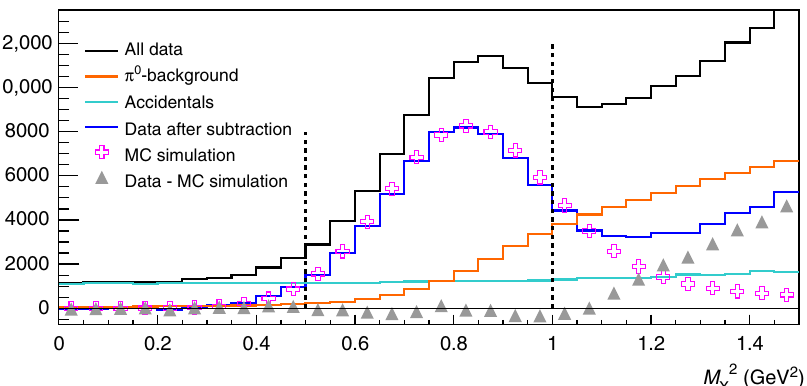
Fig. 3 Missing mass squared distribution. The black histogram presents the raw data. Accidental and π 0 backgrounds are shown in green and orange, respectively. The subtraction of the accidental and π 0 contributions from the raw data is displayed in blue. The Monte-Carlo simulation is represented by the open crosses, whereas the triangles show the estimated inclusive yield obtained by subtracting the simulation from the background-subtracted data. The vertical dotted lines illustrate the two cuts applied on M 2 in the analysis. This fi gure corresponds to the kinematic setting E beam = 4.455 GeV and Q 2 = X 1.75 GeV 2 , integrated over t